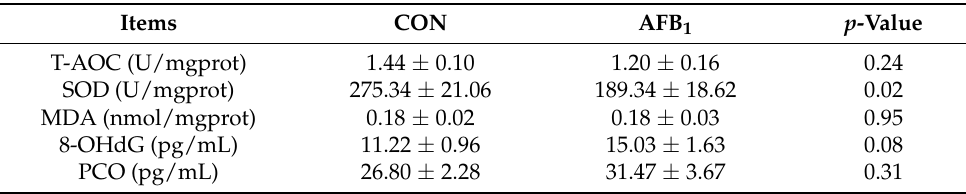
Table 9. Effects of AFB 1 on jejunal mucosal antioxidant indicators of pigs.